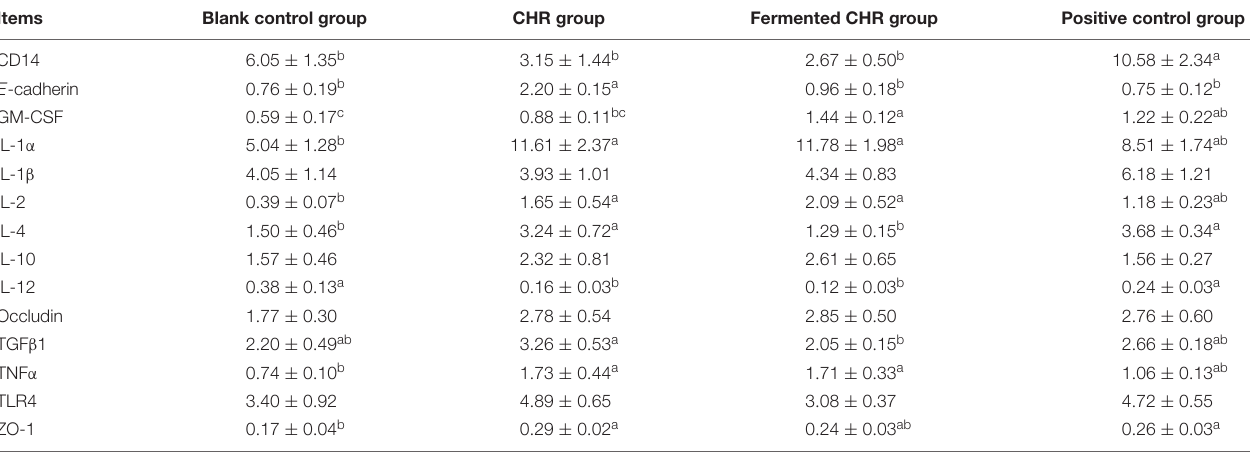
TABLE 7 | Effects of dietary supplementation with Chinese herbal residues (CHR) or fermented CHR on colon mRNA levels corresponding to epithelial cell proteins, cytokines, and TLR4 signaling pathway in weaned piglets ( n = 5).